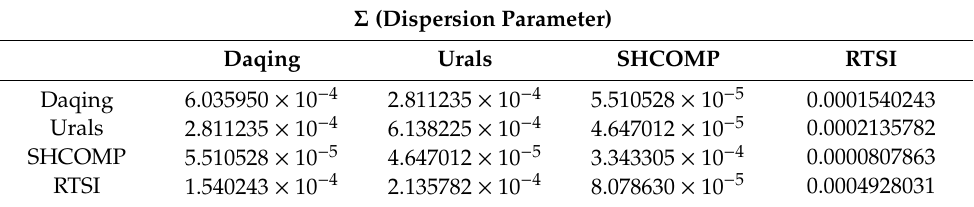
Table A19. MNIG Dispersion parameter Σ for Vector 5: Daqing, Urals, SHCOMP, RTSI.